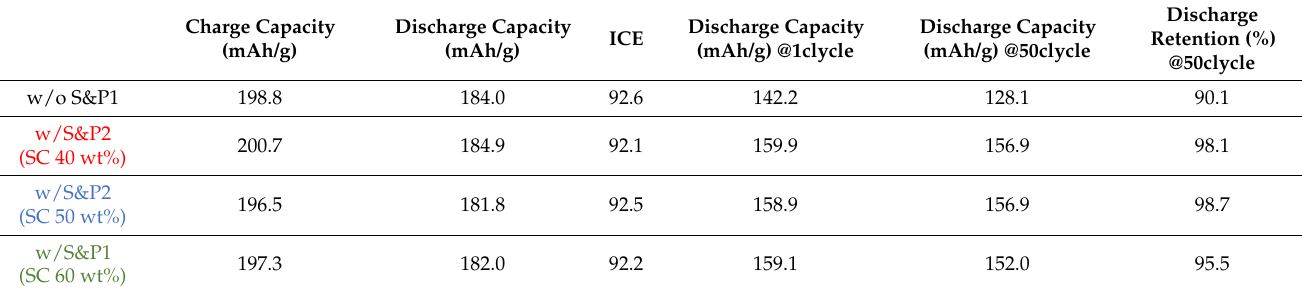
Table 2. Charge capacity, discharge capacity and initial coulombic efficiency (ICE) of without S&P1 (SC 60 wt%), with S&P2 (SC 40 wt%), with S&P2 (SC 50 wt%), and with S&P2 (SC 60 wt%) at 0.1C at